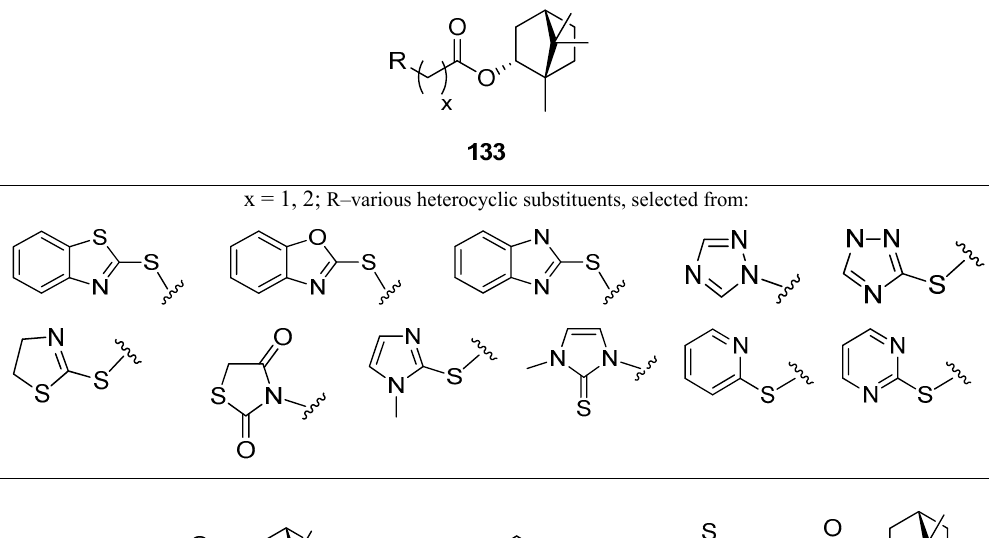
Figure 39. (–)-Borneol and (–)-isoborneol derivatives with morpholine fragment.